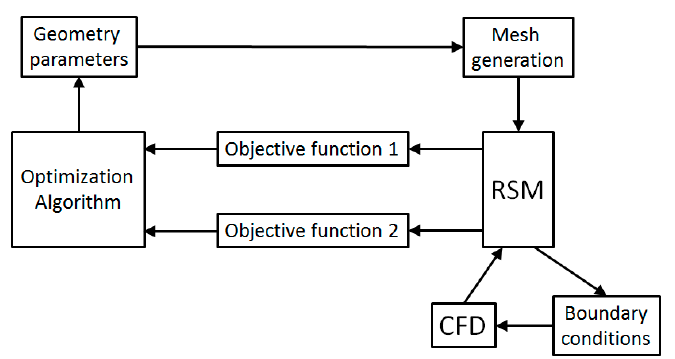
Figure 1. Optimization cycle.